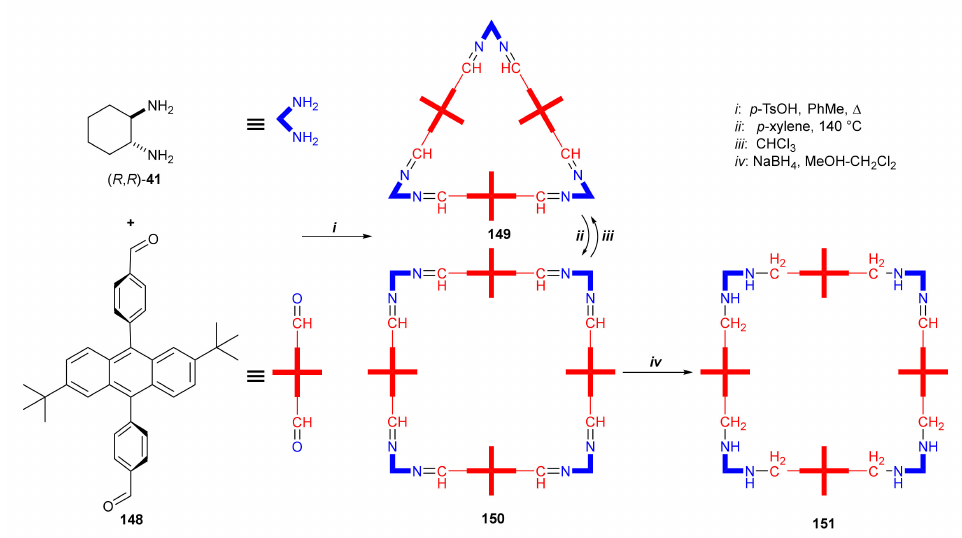
Figure 30. Synthesis of [3 + 3] ( 149 ) and [4 + 4] ( 150 ) macrocycles and their isomerization